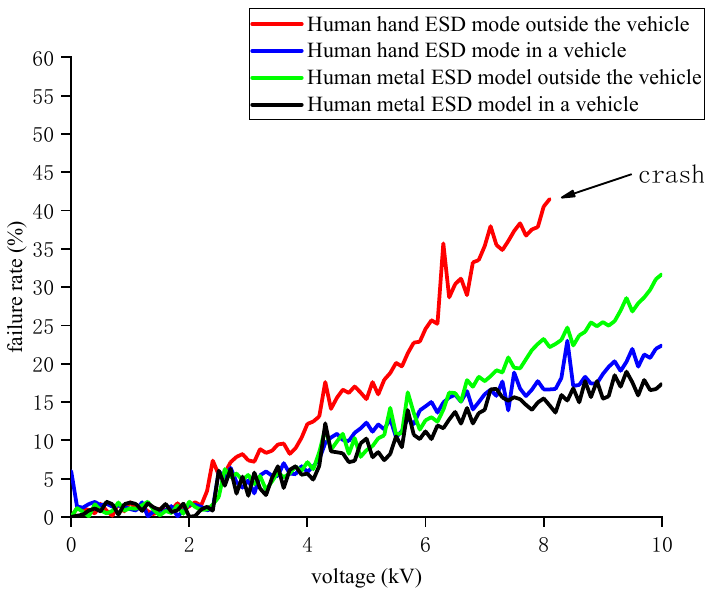
Figure 12. LiDAR failure rate.